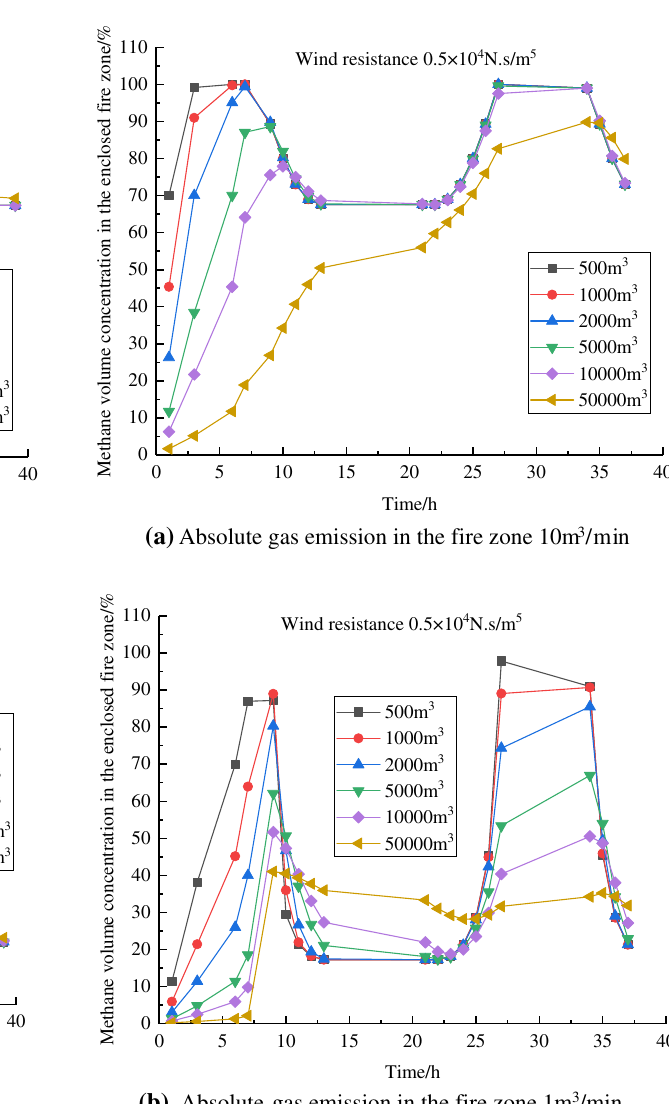
(b) Absolute gas emission in the fire zone 1m 3 /min Fig. 11 Different gas emission, different fire zone volume, and small wind resistance, the changes of gas concentration in the fire zone with time after the completion of sealing at 19:00